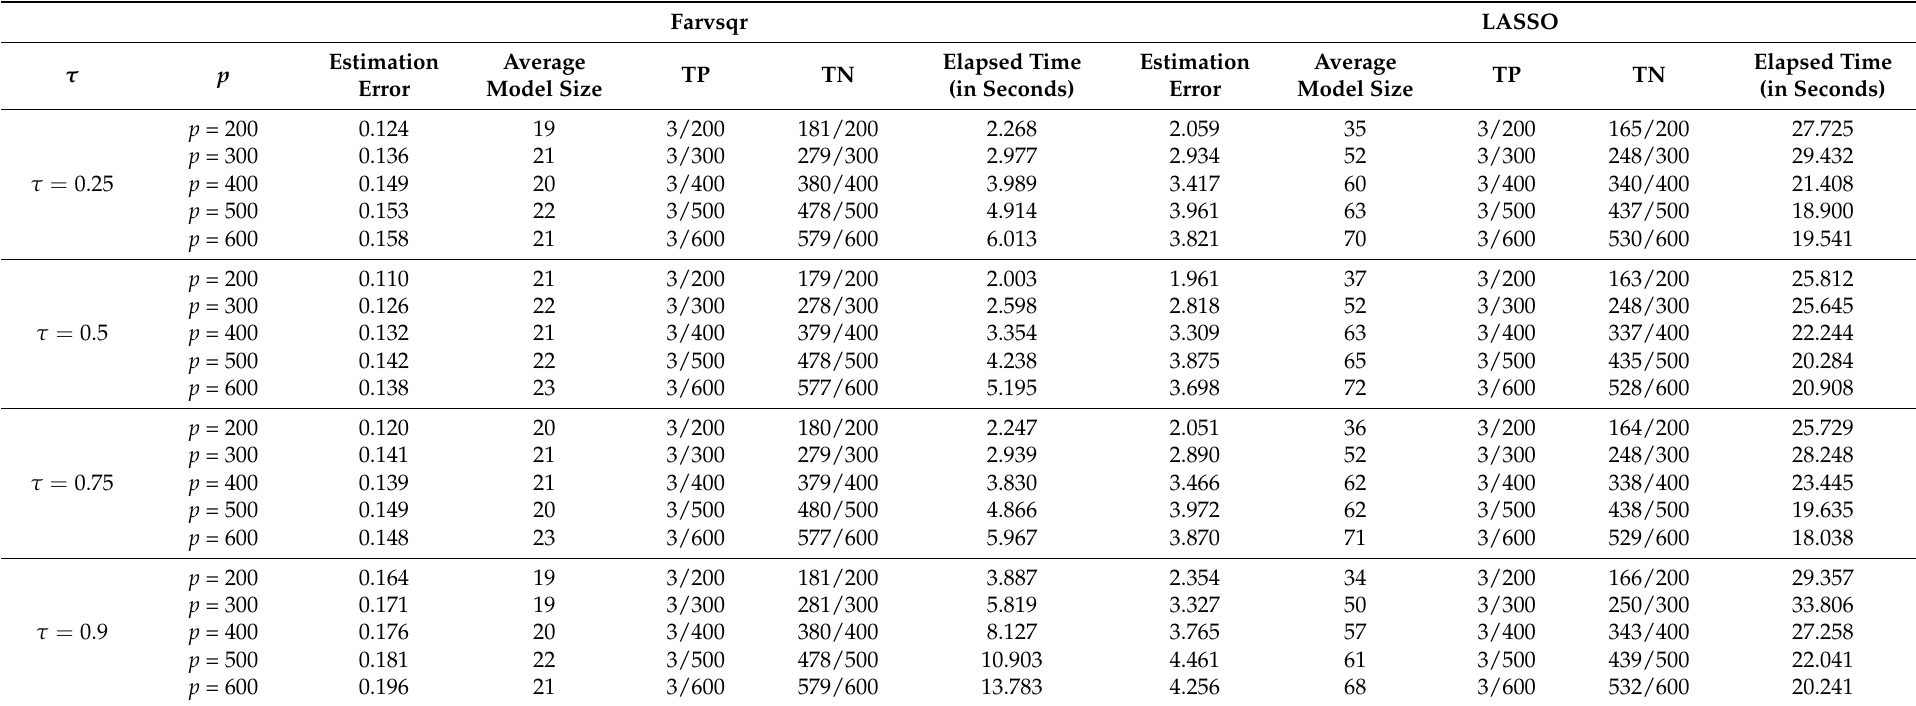
Table 4. The comparison for n = 1000, N ( 0,1 ) with the factor model. Farvsqr